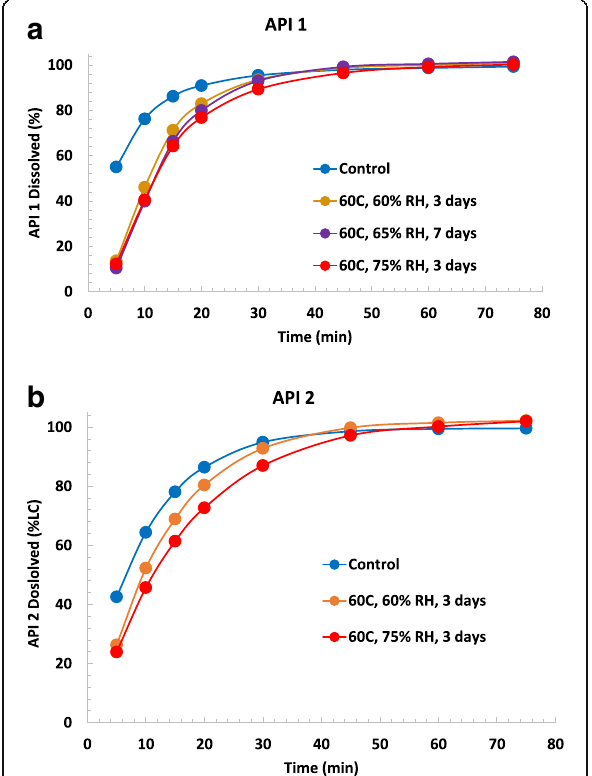
Fig. 1 a Dissolution Profiles of API 1 under Different Storage Conditions, in pH 1.5 Media. b Dissolution Profiles of API 2 under Different Storage Conditions, in pH 6.8 Media